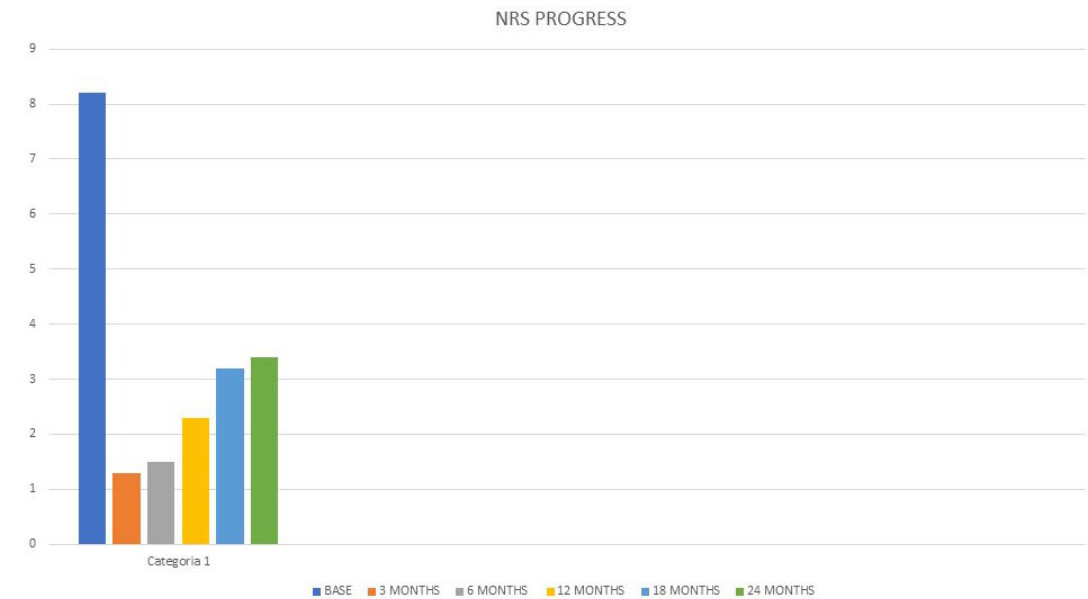
Figure 2. NRS Progress. NRS: Numerical Rating Scale.